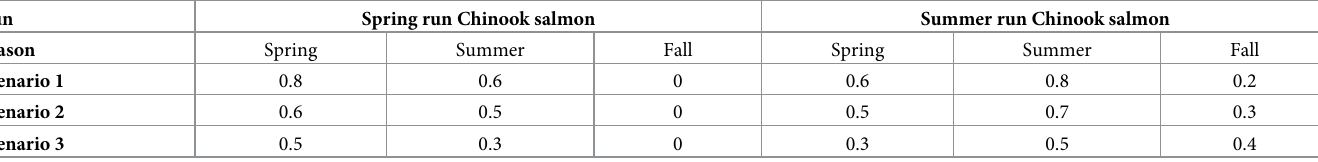
Table 4. Relative seasonal proportions P s of migrating spring and summer Chinook salmon stocks originating from the Fraser River, Puget Sound, and the Strait of